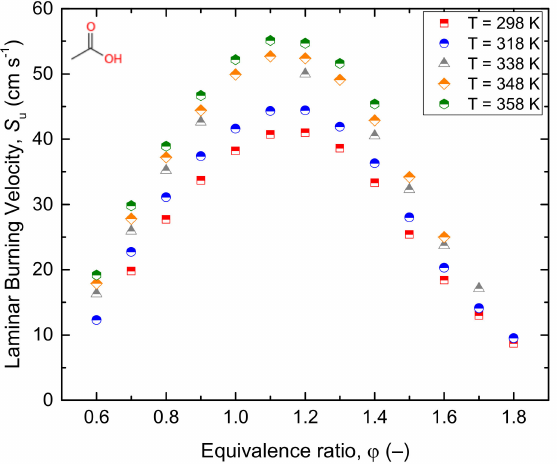
Figure 10. Laminar burning velocity data for the acetic acid/air mixture at atmospheric pressure [14].